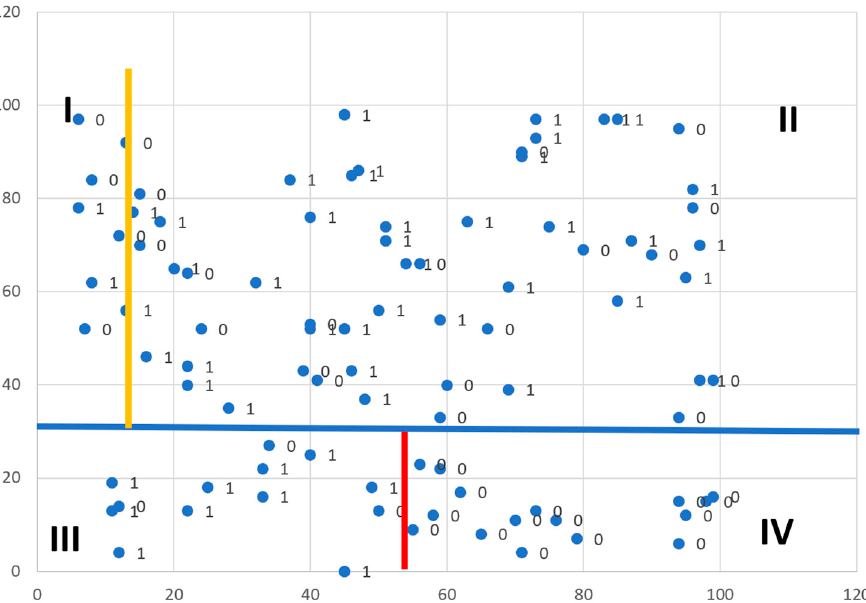
Figure 3. Example training data set showing the two classes (1 and 0) and their coordinates, x (hori- zontal axis) and y. The three lines shows three boundaries.